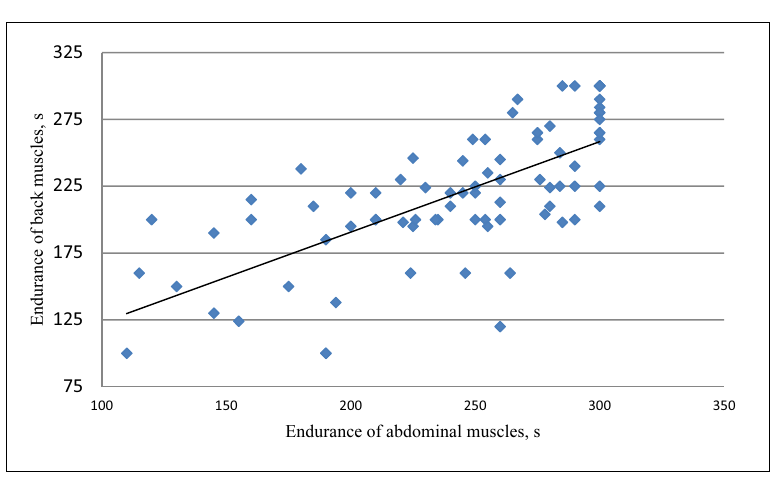
Figure 3. Correlations between the endurance of back and abdominal muscles for the study